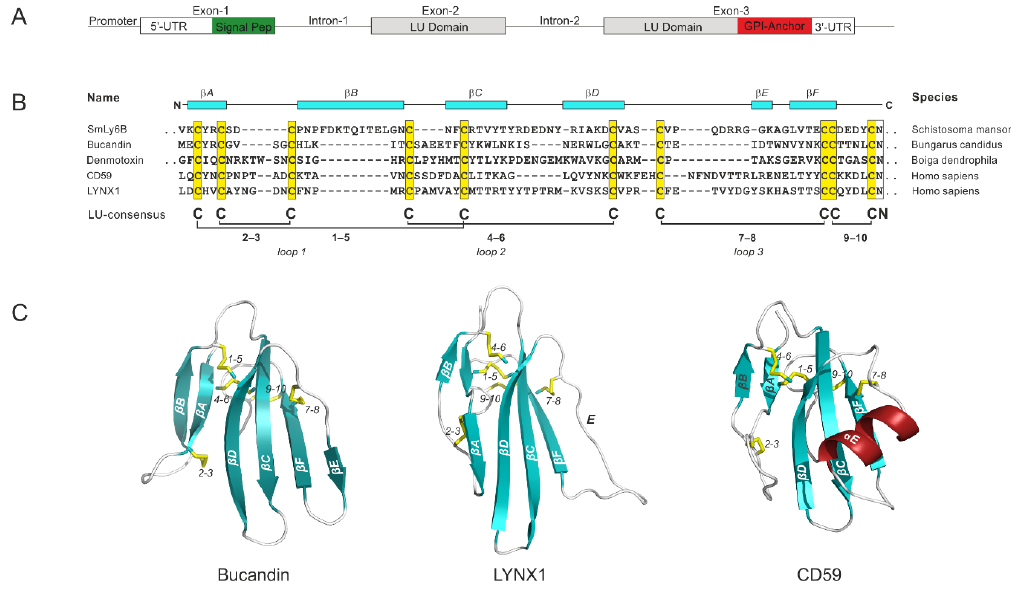
Figure 1. Characteristic properties of typical LU-domain encoding genes and their protein products: ( A ) The gene structure encoding an archetypical single LU-domain protein comprises three exons. Note that the signal sequence for GPI-anchoring is included in exon-3 for those proteins that are destined to become glycolipid anchored. ( B ) Sequence alignments of typical LU domains from di ff erent metazoan taxa where the plesiotypic 10-cysteine pattern is maintained (highlighted by yellow boxes along with the consensus disulfide bonding). Typical LU-domain secondary structure elements are shown in the top of the alignment as cyan boxes using the structure of Bucandin as reference. SmLy6B (Uniprot: B8Y6H3) from Schistosoma mansoni represents the class Trematoda [11]; Bucandin (Uniprot: P81782) from Bungarus candidus and Denmotoxin (Uniprot: Q06ZW0) from Boiga dendrophilae both represent the class Reptilia; CD59 (Uniprot: P13987) and LYNX1 (Uniprot: P0DP58) from Homo sapiens both represent the class Mammalia. Dots indicates an extension of the sequence. ( C ) The three dimensional protein structures of prototypical single LU-domain proteins are represented in a cartoon representation for CD59 [PDB 2OFS [12]], LYNX1 [PDB 2L03 [13]], and Bucandin [PDB 1F94 [14]]. The plesiotypic disulfide bonds are shown as yellow sticks and are numbered as in panel ( B ). The protruding strands forming the three loops are labelled A – F ; β -sheets are colored cyan; α -helices are colored red.